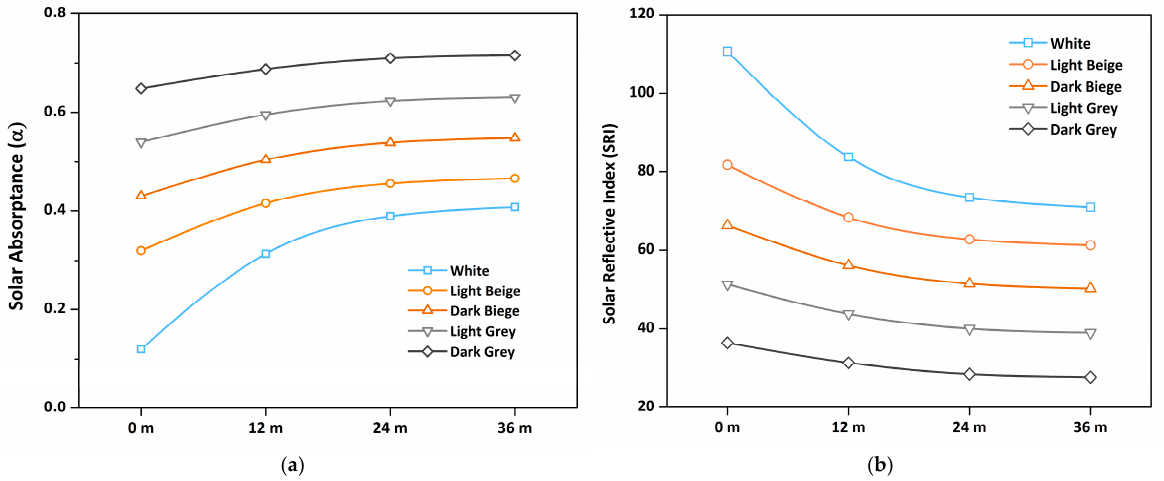
Figure 10. Natural weathering/aging trends for cool roof and wall paints. ( a ) Solar absorptance (1-solar reflectance). ( b ) Solar reflective index (SRI).